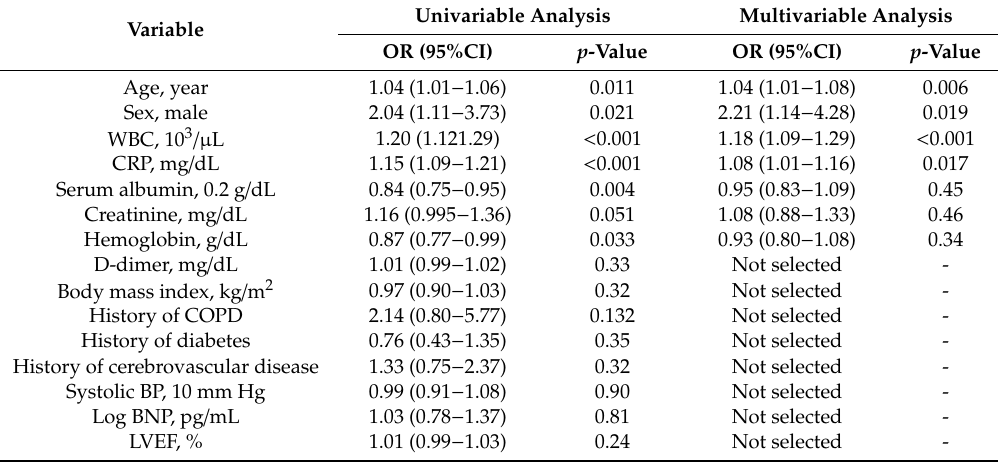
Table 4. Determinants of development of